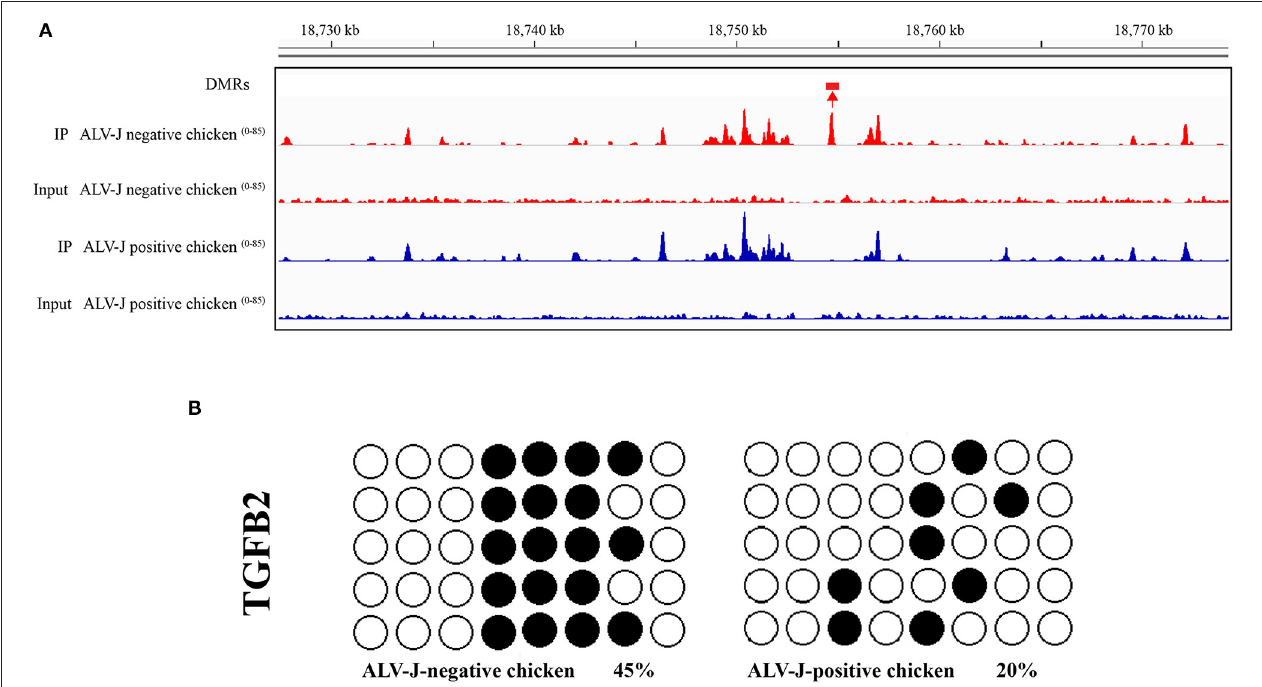
FIGURE 5 | Validation of the hypomethylated gene TGFB2 in ALV-J- positive chicken samples vs. ALV-J- negative chicken samples by bisulfite sequencing. (A) Visualization of the DMRs in TGFB2, using the IGV tool. DMR is indicated by boxes above the tracks. Scales are showed on the left; (B) the validation result of the DMRs of TGFB2 in the promoter region by bisulfate sequencing. Black circles indicate the methylated CpG locus and white circles indicate the unmethylated CpG locus. The chi-square test showed the differences between ALV-J-negative and ALV-J-positive